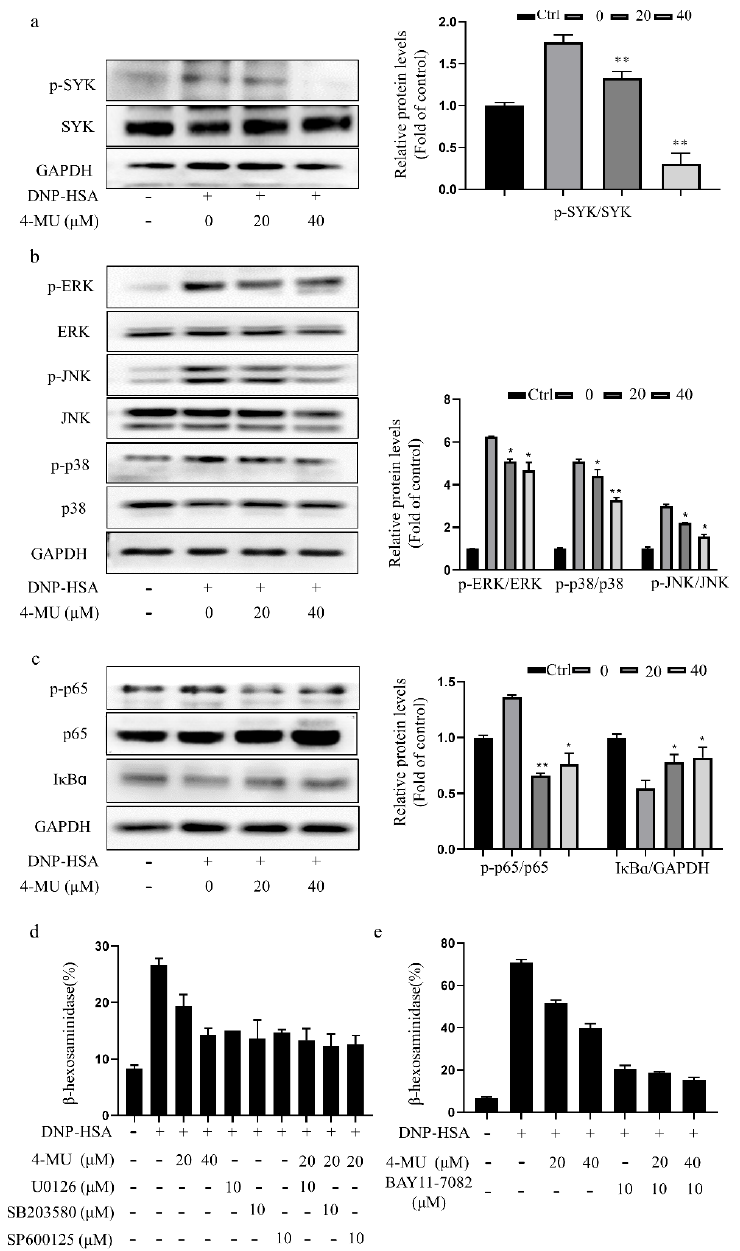
Figure 3. 4-MU suppresses Fc ε RI-mediated signaling protein activation in RBLs. IgE-sensitized RBLs were pre-incubated with 4-MU for 1 h and then stimulated with DNP-HSA for 20 min. ( a – c ) Western blot analysis of SYK ( a ), MAPK (p38, ERK, and JNK) ( b ), and NF- κ B pathway signaling molecules (p-p65, p65, and I κ B α ) ( c ) in activated RBLs. ( d , e ) β -Hexosaminidase release from IgE-activated RBLs treated with 4-MU and MAPK inhibitors (ERK inhibitor U0126, JNK inhibitor SP600125, and p38 inhibitor SB203580) ( d ) or the NF- κ B inhibitor BAY 11-7082 ( e ) for 1 h prior to the DNP-HSA challenge. Means (of three duplicate experiments) ± SDs are shown; * p < 0.05, ** p < 0.01 vs. activated cells without treatment. Abbreviations as in Figure